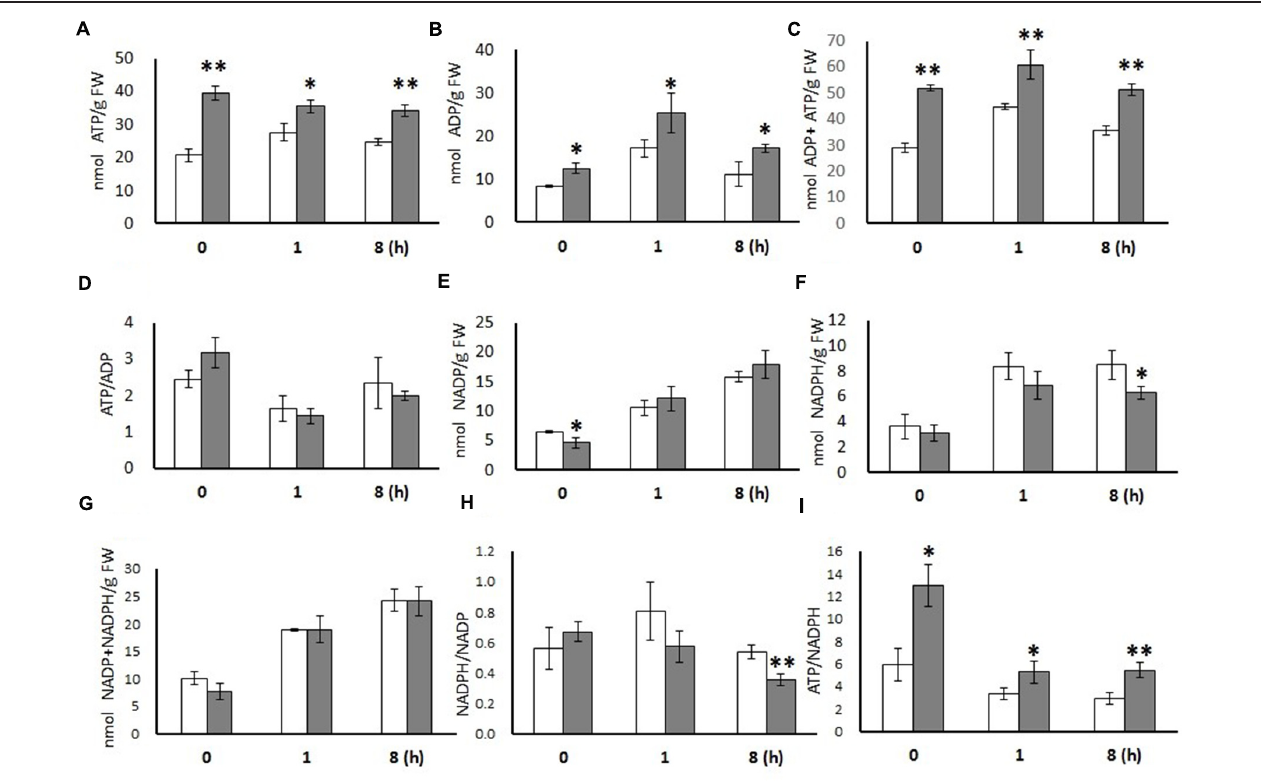
FIGURE 1 | Metabolites measured from 20-days-old leaves of WT and OE7 Arabidopsis at different time points. ATP (A) , ADP (B) , ADP + ATP (C) , ATP/ADP (D) , NADP (E) , NADPH (F) , NADP + NADPH (G) , NADPH/NADP (H) , and ATP/NADPH (I) . Data are expressed (nmol/g FW) as means with ± SD of three biological replicates. Independent sample t -test using IBM SPSS Statistics 19 Software. Asterisks indicate significant difference between WT (white bar) and OE (gray bar), ∗ P < 0.05, ∗∗ P < 0.01. FW, Fresh weight.